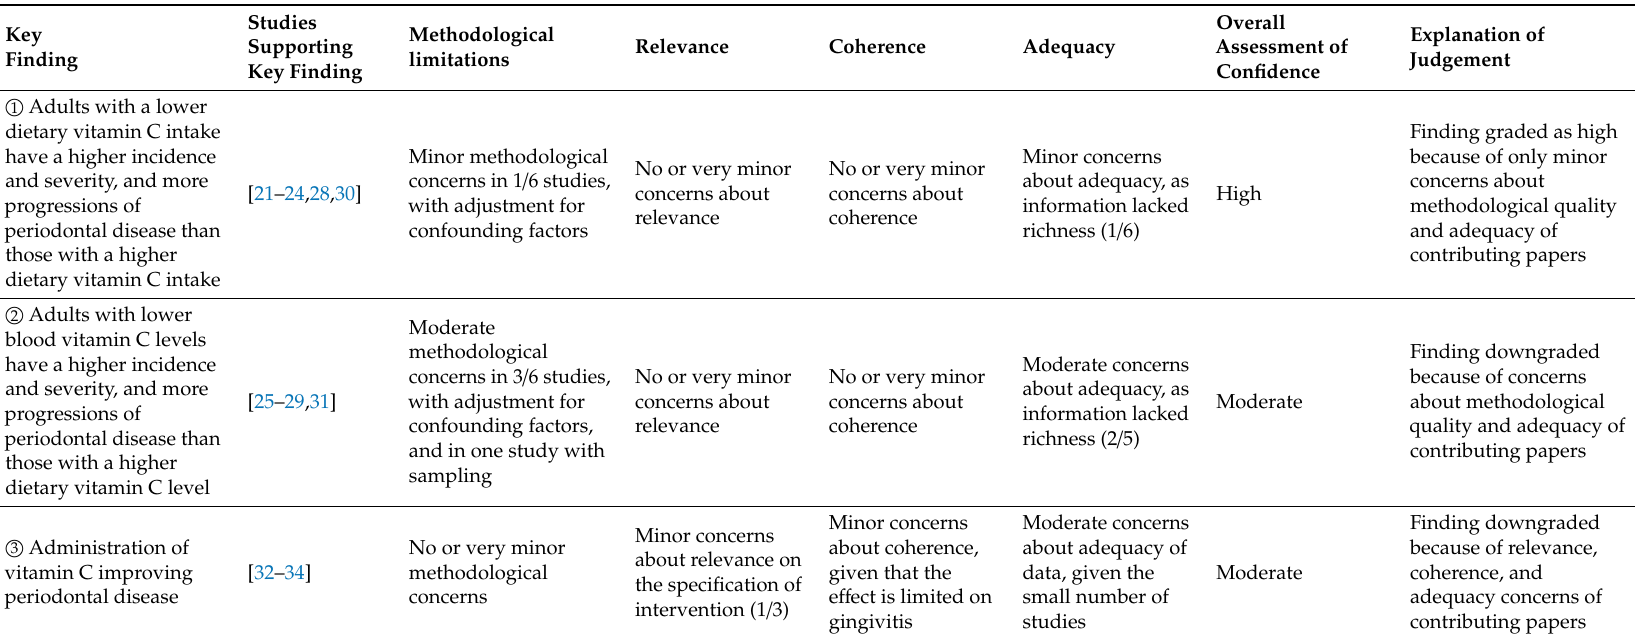
Table 5. The results of CERQual